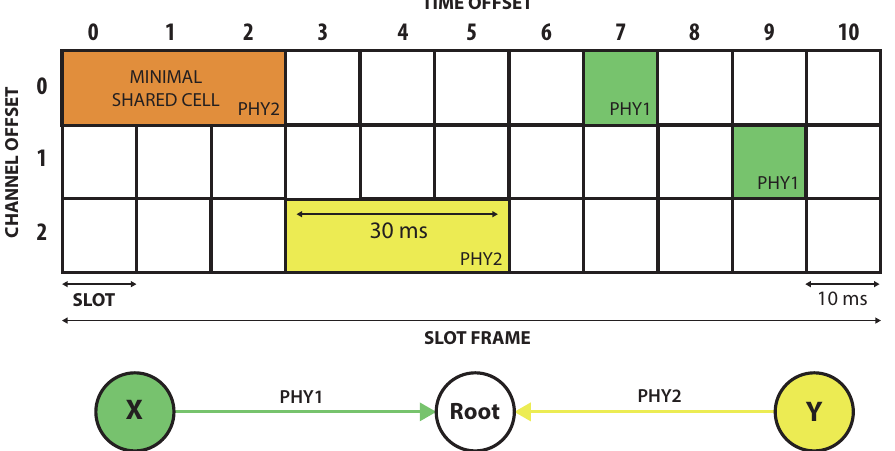
Figure 1. A TSCH schedule with regular slots of 10ms length. Node X uses physical layer PHY1 that only requires one regular time slot of 10ms. For accommodating physical layer PHY2 on the link from node Y to the root, three slots are bonded together to a 30ms slot. For the minimal shared cell, the most robust PHY2 is